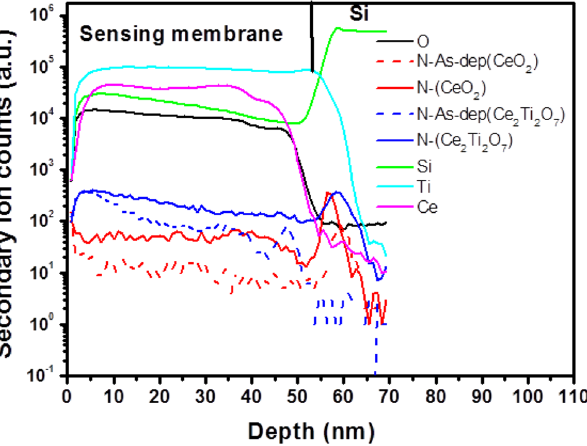
Figure 5. SIMS profiles of CeO 2 or Ce 2 Ti 2 O 7 sensing membrane/Si with NH 3 plasma treatment.